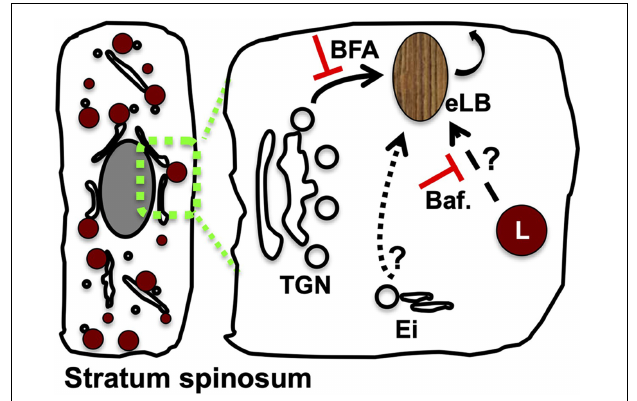
FIGURE 2 | Modulation of Golgi or lysosome function alters the epidermal LB biogenesis and homeostasis. A set of TGN-derived vesicles possibly acts as the precursors of eLB in the differentiated keratinocytes of the spinosum layer, which matures into functional LBs post sequential maturation by receiving the cargo/membranes from the endolysosomal system (indicated as arrows). Several studies support this model: (a) inhibition of Golgi function with brefeldin A (BFA) blocks (shown as red color T) the production of epidermal lysosomes (L) (Mahanty et al., 2019) and LBs (Madison and Howard, 1996) and also inhibits keratinocyte differentiation (Mahanty et al., 2019); (b) inhibition of lysosome function by using bafilomycin (Baf.) causes defective epidermal architecture (shown as red color T) (Monteleon et al., 2018) and also inhibits the keratinocyte differentiation (Mahanty et al., 2019); and (c) silencing of Rab11A or knockout mouse of VPS33B or VIPAR displays defective eLB biogenesis, and barrier function suggests a role for Ei (consists of early/recycling endosomes) during their biogenesis (Reynier et al., 2016; Rogerson and Gissen, 2018). The drawn hypothetical model is based on the stepwise cargo transport to maturing TGN-derived precursor organelles, which generate functional eLBs. Differentiated keratinocyte of the stratum spinosum layer was shown on the left. The possible cargo trafficking routes to eLBs are indicated in the enhanced portion on the right side.